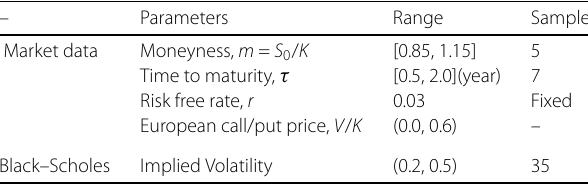
Table 5 The range of market quotes – Parameters Range Samples Market data Moneyness, m = S 0 / K [0.85, 1.15] 5 Time to maturity, τ [0.5, 2.0](year) 7 Risk free rate, r 0.03 Fixed European call/put price, V / K (0.0, 0.6) – Black–Scholes Implied Volatility (0.2, 0.5)